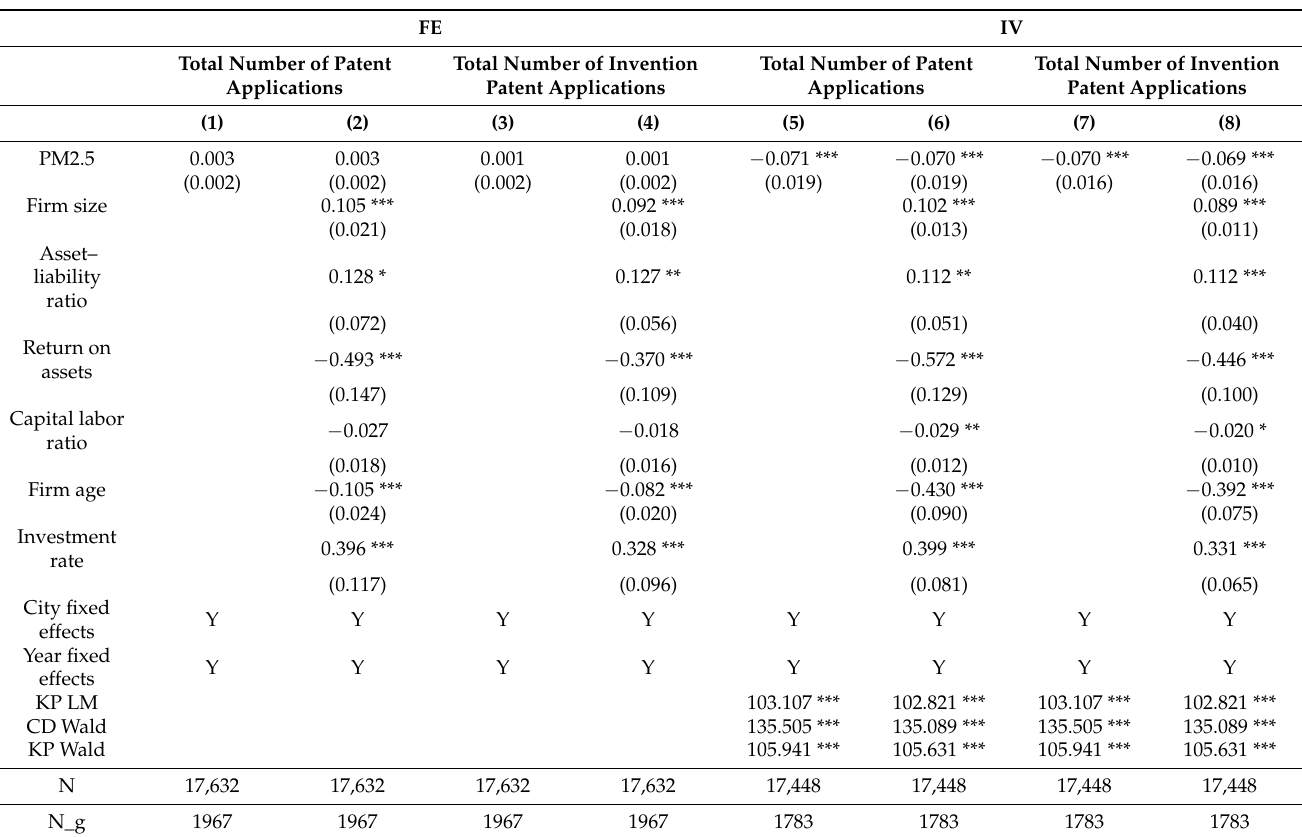
Table 2. Effects of PM2.5 on innovation. FE